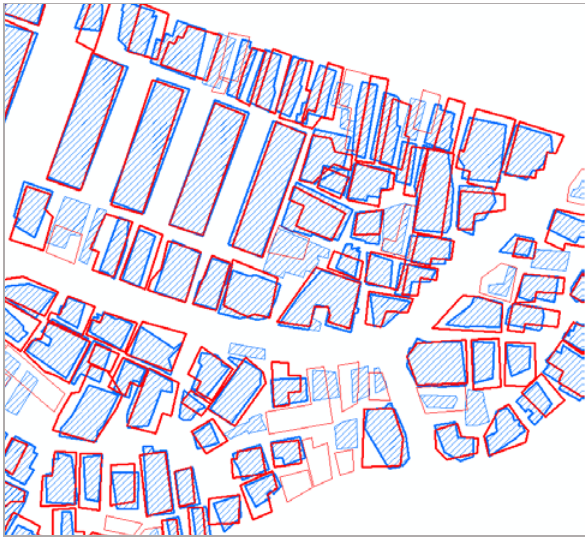
Figure 4. Visual evaluation of the matching pairs that were detected (thick